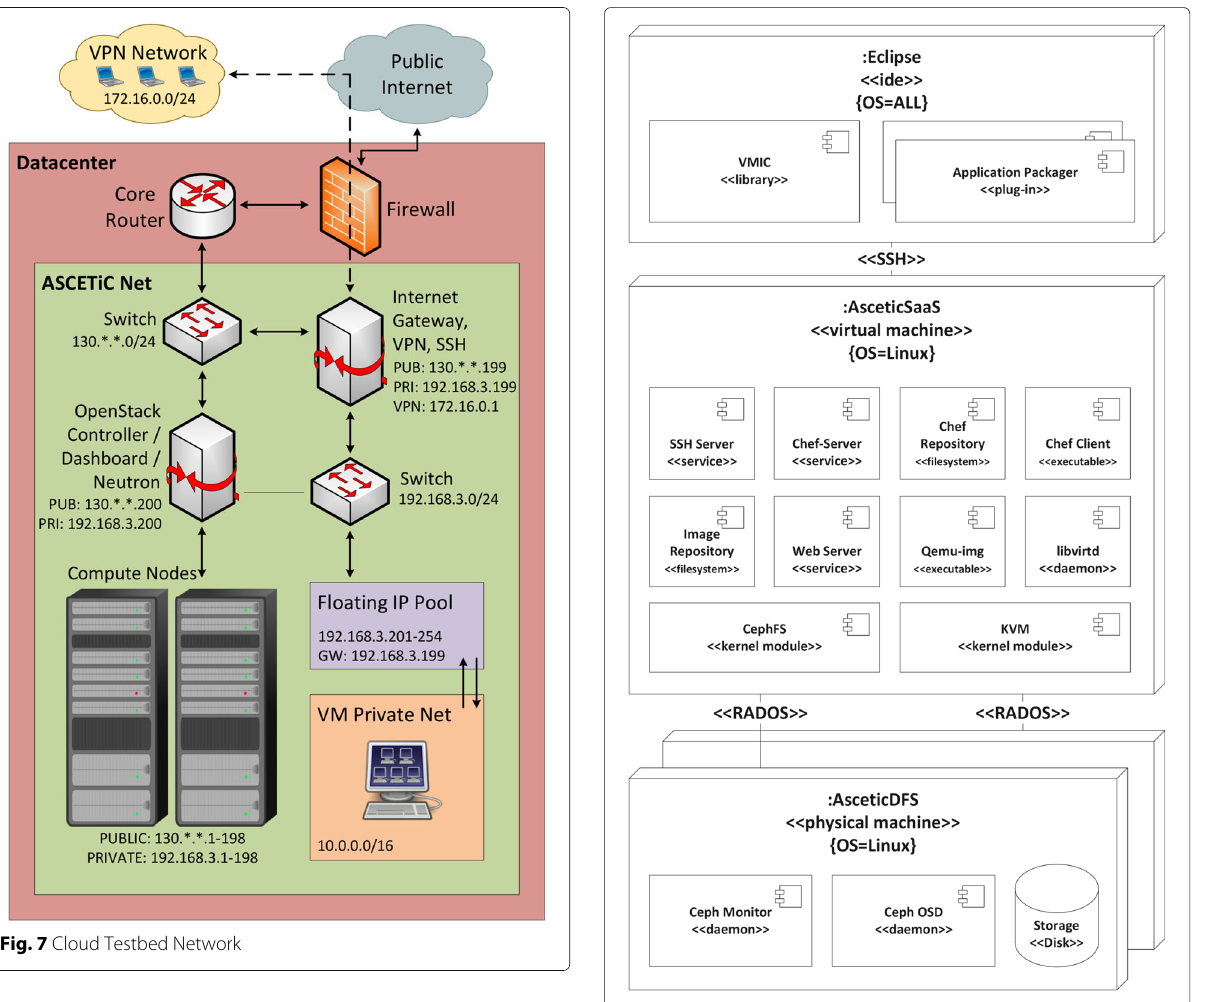
Fig. 8 VMIC Deployment